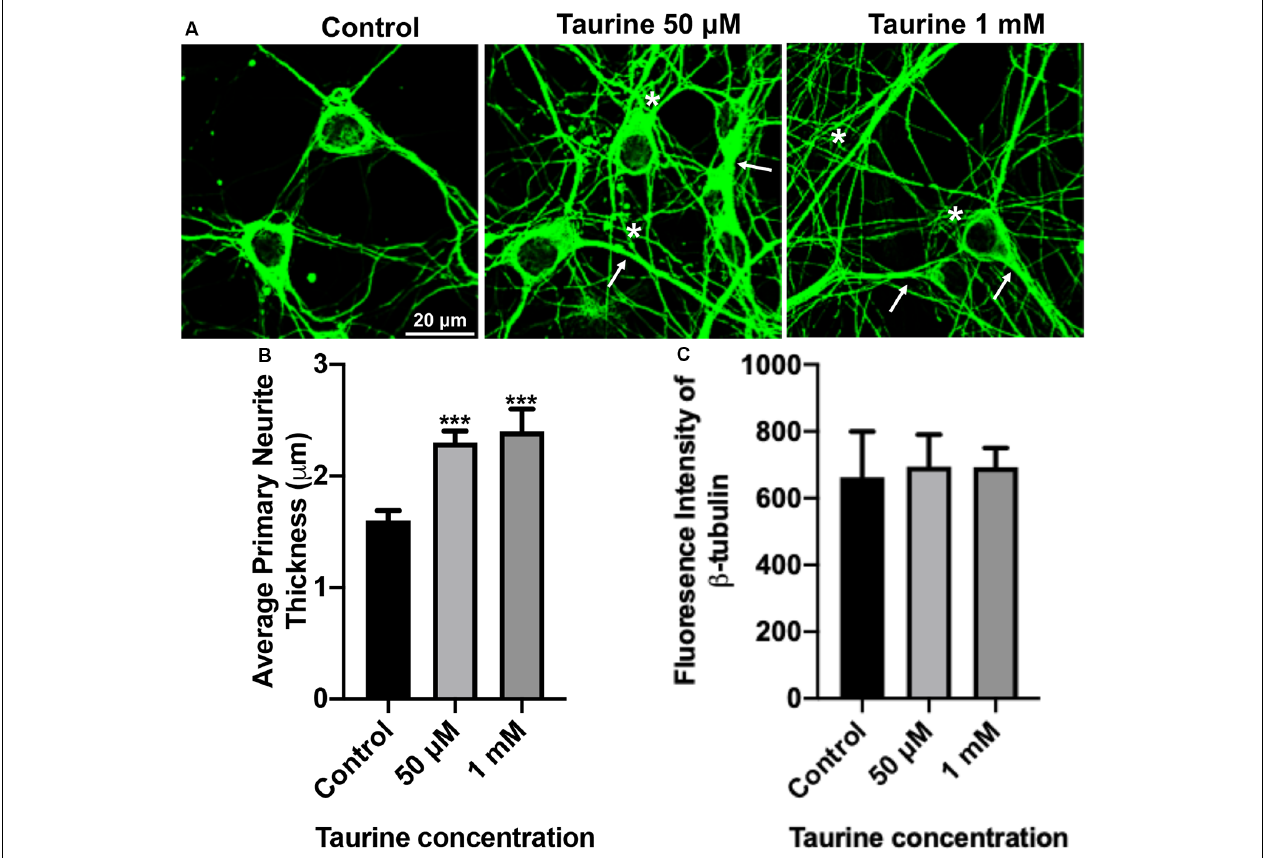
FIGURE 2 | β -tubulin-labeled cortical neurons reveal an increase in the thickness of neurites after taurine treatment. After 3 days in taurine-rich (50 µ M or 1 mM) or -free media, cortical neurons were stained with the cytoskeletal marker β -tubulin and imaged. (A) Representative images demonstrate the extensive outgrowth of cultures in all treatments and control. Arrows indicate examples of extensive neuritic processes while asterisks show robust interconnections. (B) Taurine at both 50 µ M and 1 mM concentrations significantly increased the average thickness of primary neurites compared to control. The average neurite thickness for control was 1.6 ± 0.09 µ m, for 50 µ M taurine was 2.3 ± 0.1 µ m, and for 1 mM taurine was 2.4 ± 0.2 µ m ( p = 0.0004 for control vs. 50 µ M taurine, and p = 0.0002 for control vs. 1 mM taurine). (C) The intensity of β -tubulin was not significantly changed by any concentration of taurine. Specifically, the β -tubulin intensity of control was 663.3 ± 136.2, for 50 µ M taurine was 694.3 ± 96.3, and for 1 mM taurine was 692.5 ± 58.3 ( p = 0.971; n = 4 images per treatment and number of neurites analyzed was 40, 39, and 30 for control, 50 µ M taurine, and 1 mM taurine, respectively; the statistical test was one-way ANOVA in all cases). ***Indicates a significance level of p < 0.001 vs.